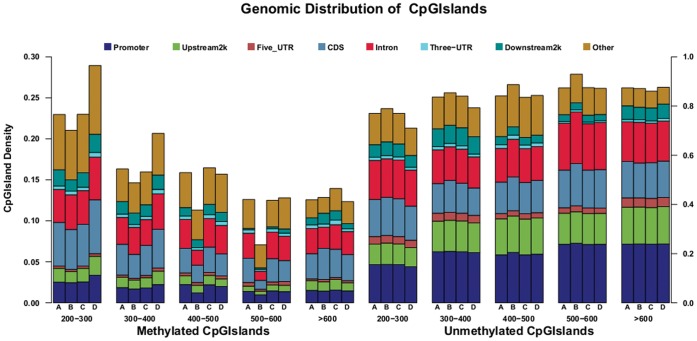
Genomic distribution of methylated and unmethylated CpG islands.We subdivided CpG islands into methylated and unmethylated islands and then categorized them into different bins according to their sizes. A. Genomic distribution of methylated CpG islands. B. Genomic distribution of unmethylated CpG islands. The number of CpG islands in a particular bin was calculated in different regions and subsequently it was normalized by the total number of CpG islands in that bin. Here the genomic region 2 kb upstream and downstream of the transcription start site was regarded as promoter. A, B, C, and D indicated the group of Recessive White Rock with high body weight (WRRh), Recessive White Rock with low body weight (WRRl), Xinhua Chickens with high body weight (XHh), and Xinhua Chickens with low body weight (XHl), respectively.